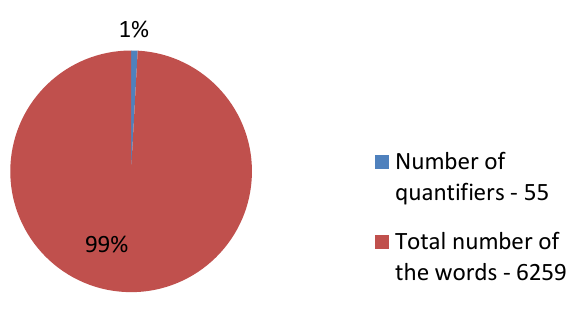
Fig. 2 – Expression of identifies in